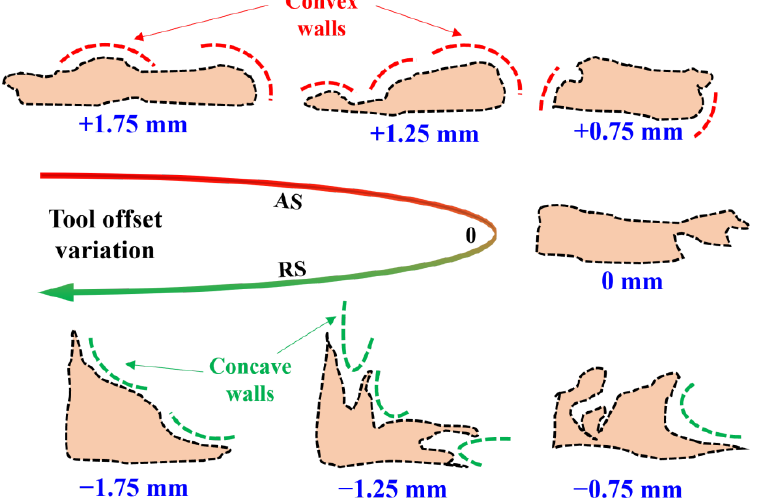
Figure 5. Defect morphology variation from convex to concave walls due to change in tool offset positions.